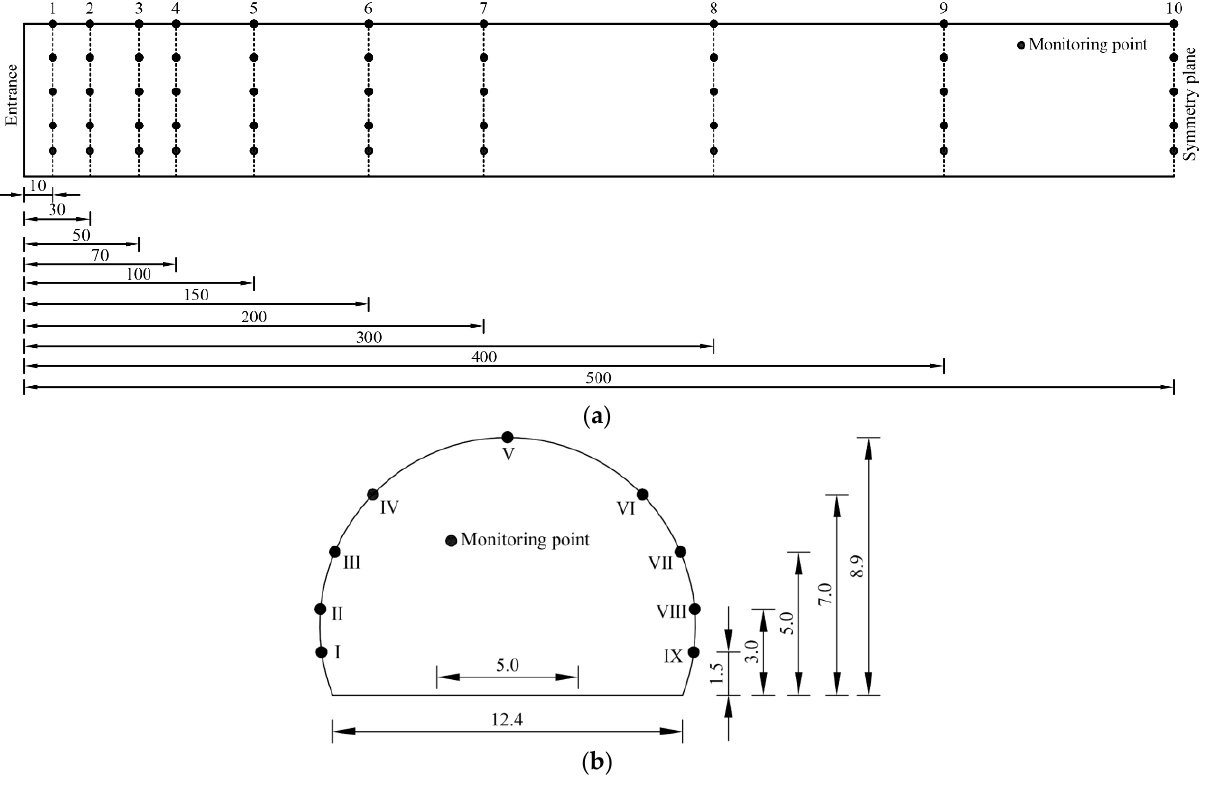
Figure 8. Layouts of monitoring points (unit: m). ( a ) Longitudinal section; ( b ) Cross section. We use the labels in the form of “1-II” to indicate the locations of monitoring points on the tunnel wall. The Arabic numerals in the labels show the cross-section ID, and the Roman numerals show the ID of the monitoring points in each monitoring